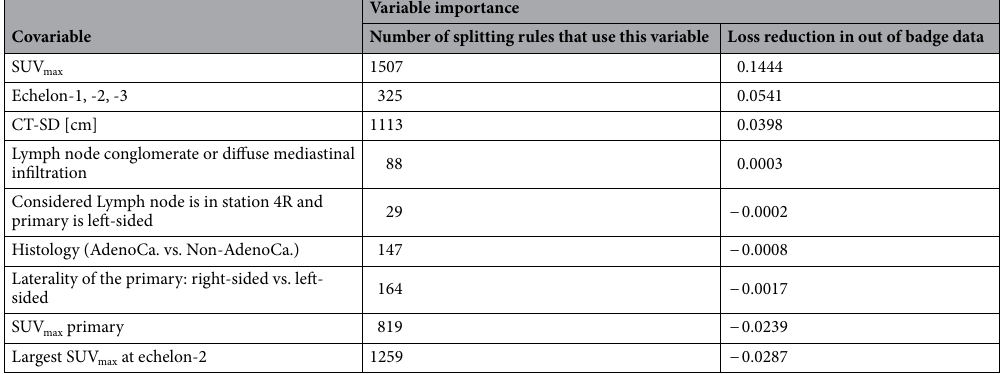
Sensitivity = 94.5% by Weighting factor = 9 Cut-off Pr = 0.50